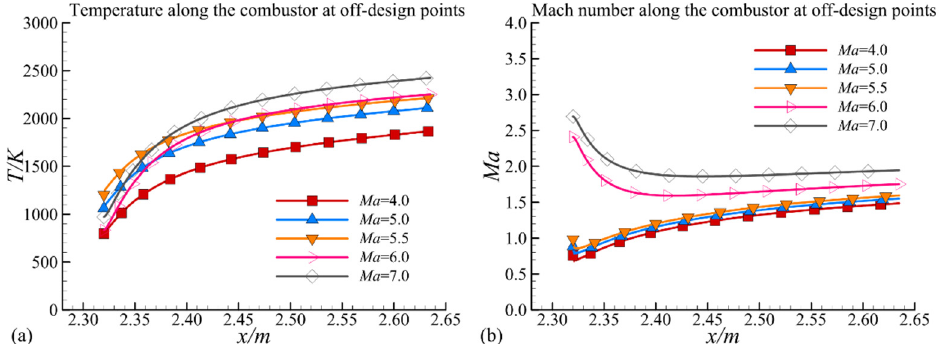
Figure 13. Temperature and Mach number along the combustor from Mach number 4 to 7. ( a ) Tem- perature of the hypersonic vehicle from Mach number 4 to 7; ( b ) Mach number of the hypersonic vehicle from Mach number 4 to 7.